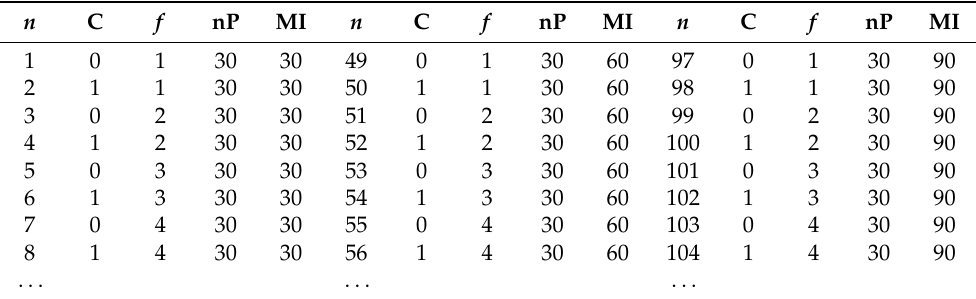
Table 4. Extract of the analyzed scenarios ( n —experiment number, C—intercept present or not, f —function type, nP—population size, and MI—maximum iteration